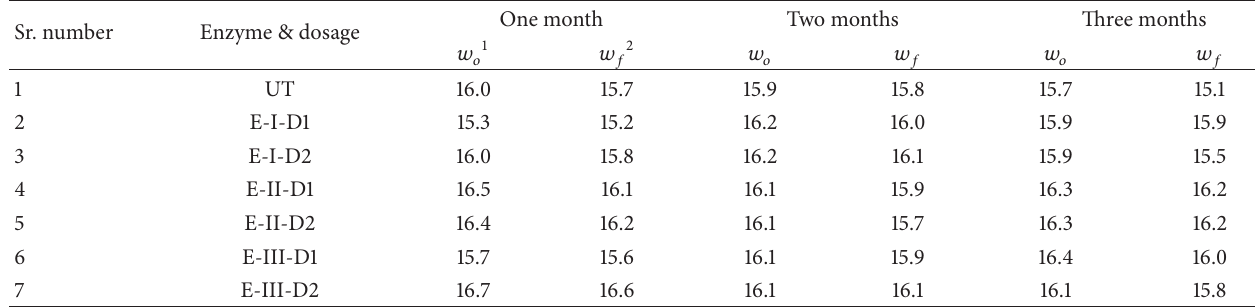
Table 4: Moisture content of prepared samples.